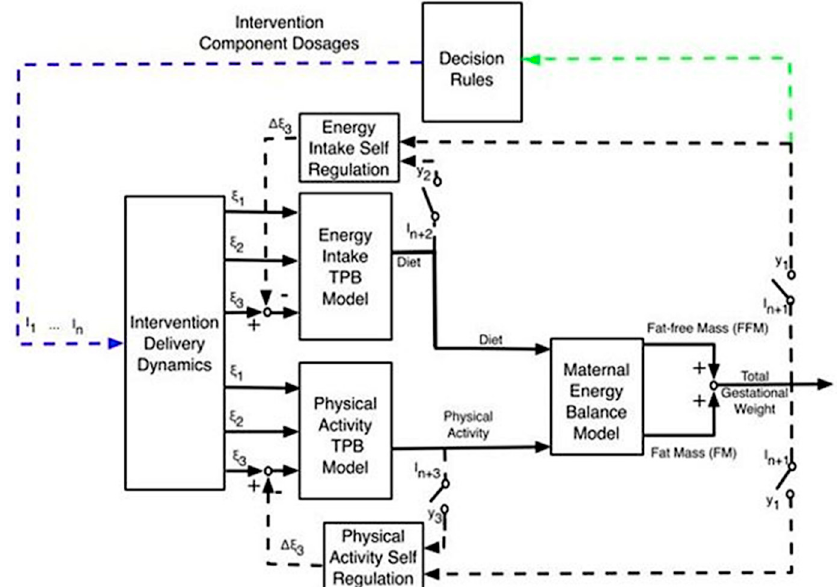
Figure 1. Dynamical model of energy balance. TPB: Theory of Planned Behavior; I 1 ... I n : Intervention components; i: exogenous variables that serve as inputs for behavioral models; y i : system outputs; ξ 1 : Behavioral belief × evaluation of outcome; ξ 2 : Normative belief × motivation to comply; ξ 3 : Control belief × power of control belief; I 1 : Healthy Eating Education; I 2 : Healthy Eating Weekly Plan; I 3 : Healthy Eating Active Learning; I 4 : Goal Setting; I 5 : Physical Activity Education; I 6 : Physical Activity Weekly Plan; I 7 : Physical Activity Session; I 8 : Daily Weight Scale; I 9 : Dietary Record; I 10 : PA monitor